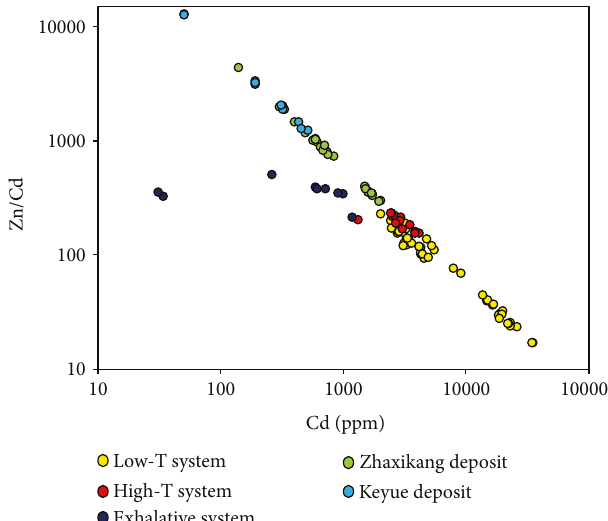
Figure 12: Diagram of Zn/Cd ratios versus Cd for sphalerite from the Keyue Sb – Pb – Zn – Ag deposit, compared with the Zhaxikang deposit (data cited from [9, 20]), as well as high-temperature (porphyry, magmatic hydrothermal, skarn, and VMS-type Pb – Zn deposit), low-temperature (MVT deposits), and exhalative systems (SEDEX-type Pb – Zn deposits and the sea fl oor hydrothermal sul fi des; data cited from Wen et al. [59]).